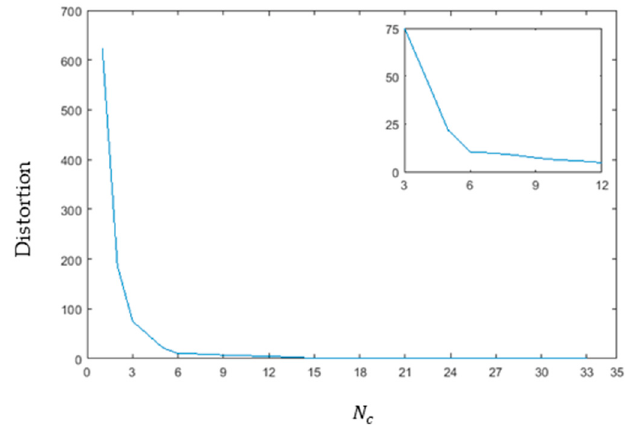
Figure 3. The distortion in k-means results under a different cluster number, 𝑁 𝑐 .